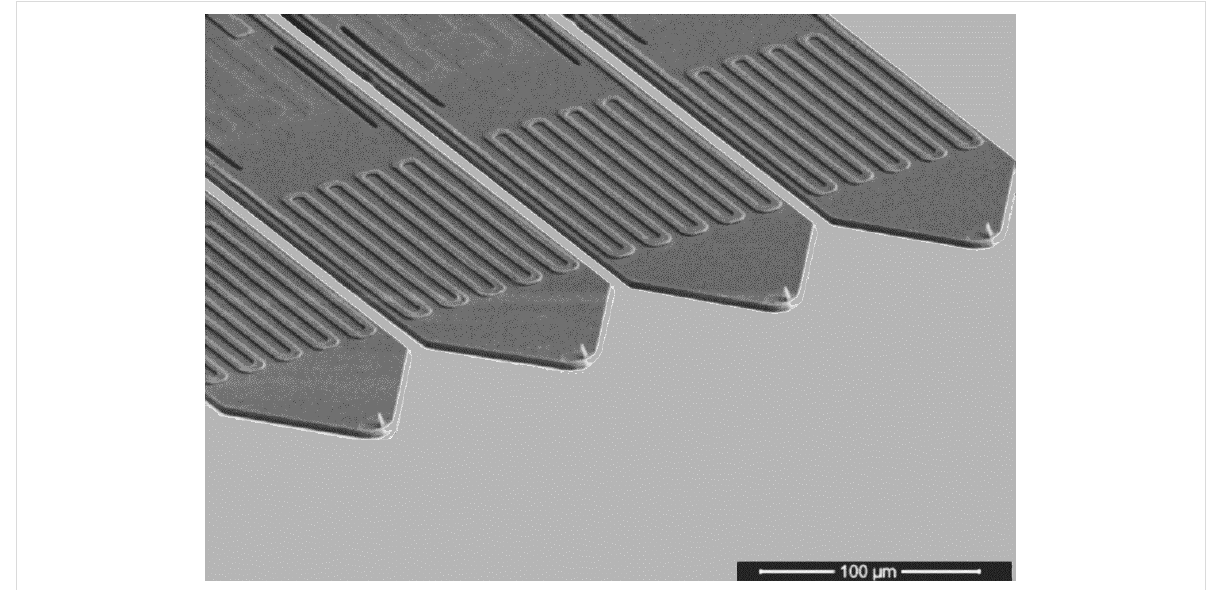
Figure 23: SEM image of Quattro cantilever array used for parallel AFM imaging with four cantilevers.